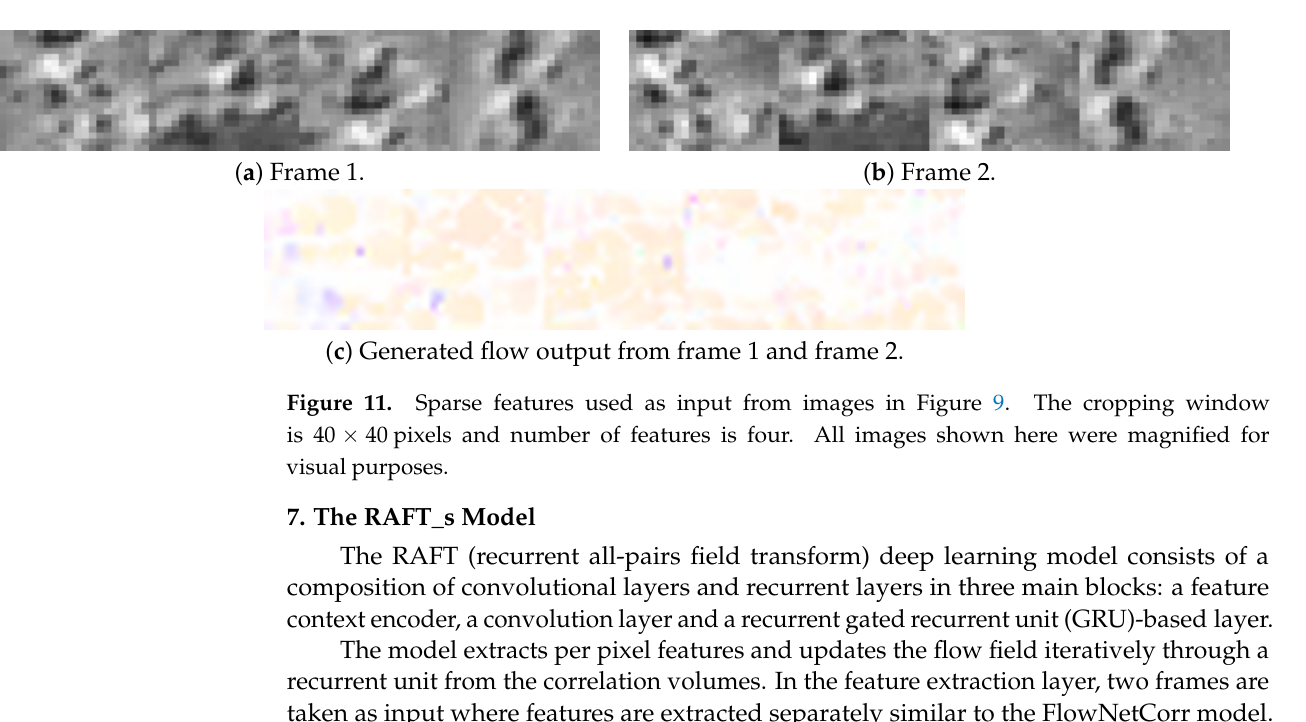
Figure 10. Flowchart shows our proposed technique. The dense network is trained with original images and ground truth. The big yellow block shows the process of our method to select good features with Shi–Tomasi technique, combine with predefined parameters to crop original frames and reconstruct new frames from those sub-images, which are the new inputs to the neural network.